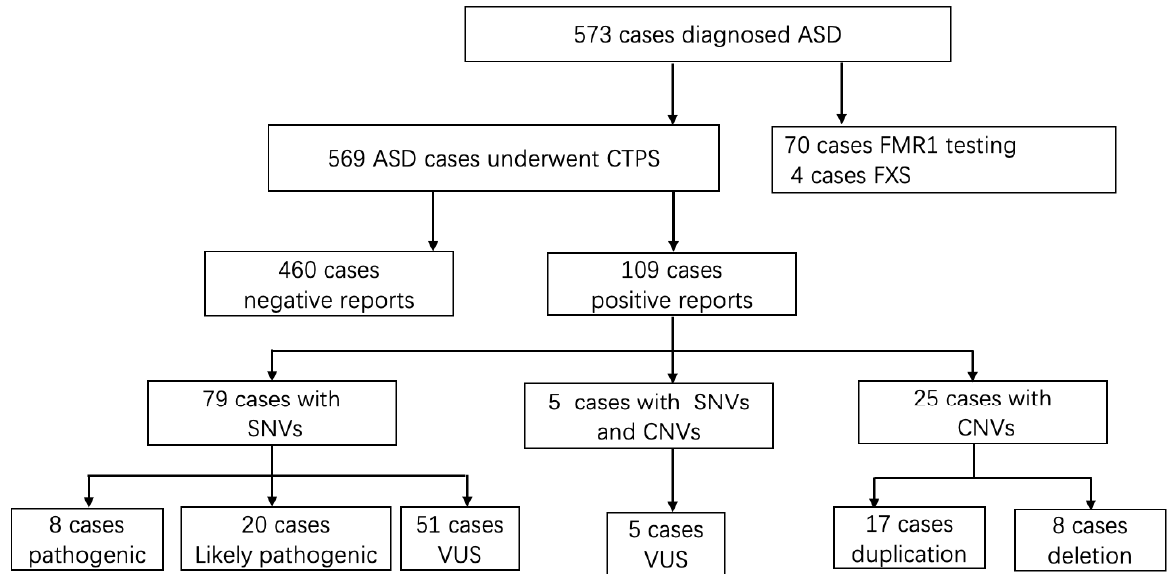
Figure 1. The flow of genetic evaluation of 573 cases with autism spectrum disorders in genetic clinics. ASD, autism spectrum disorder; CTPS: clinical targeted panel sequencing; FXS: Fragile X syndrome; SNVs: single nucleotide variations; CNVs, copy number variations; VUS, variant of unknown significance.